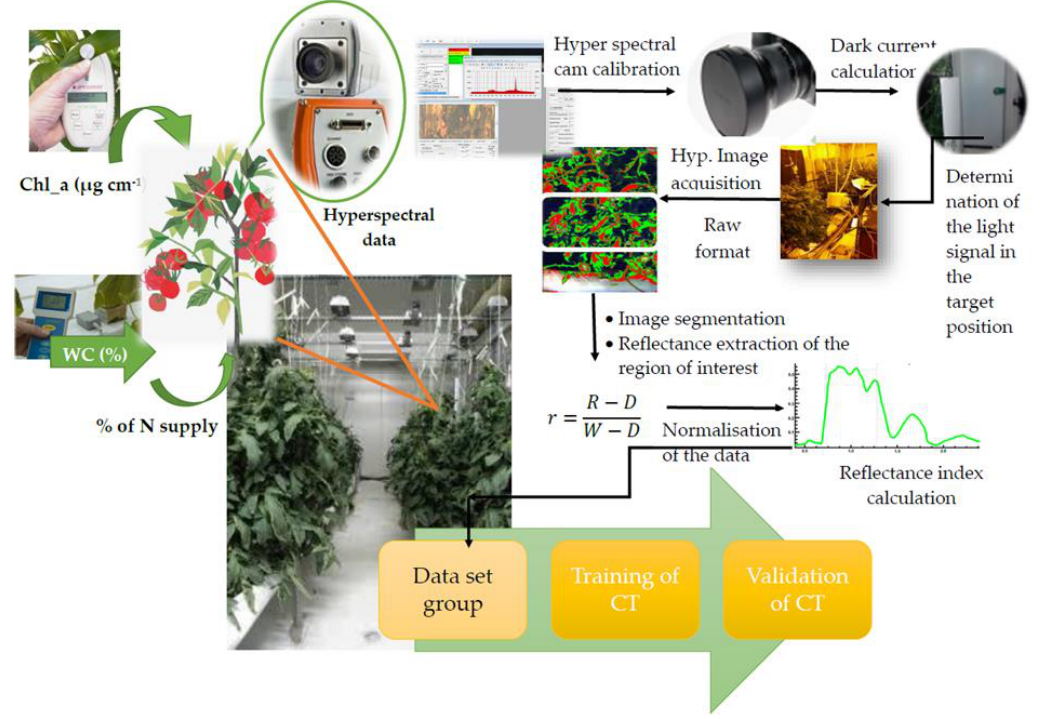
Figure 1. The experimental procedure for collecting 160 dataset groups to train and validate the system.